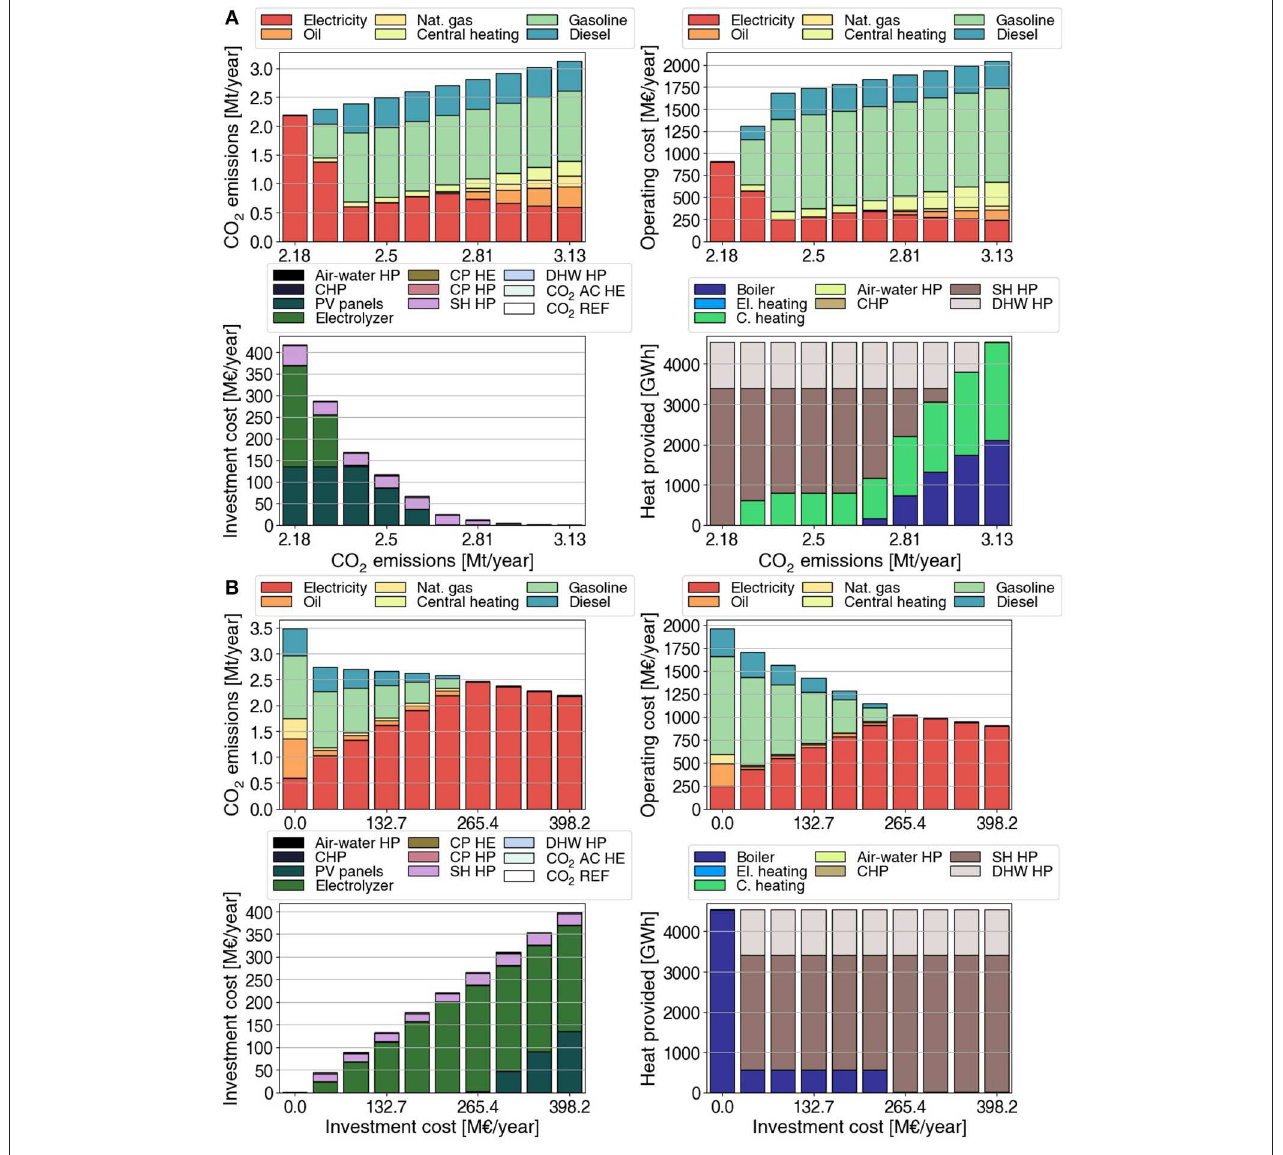
FIGURE 11 | Key performance indicators for CO 2 emission ǫ -constraints (A) and for investment cost ǫ -constraints (B)